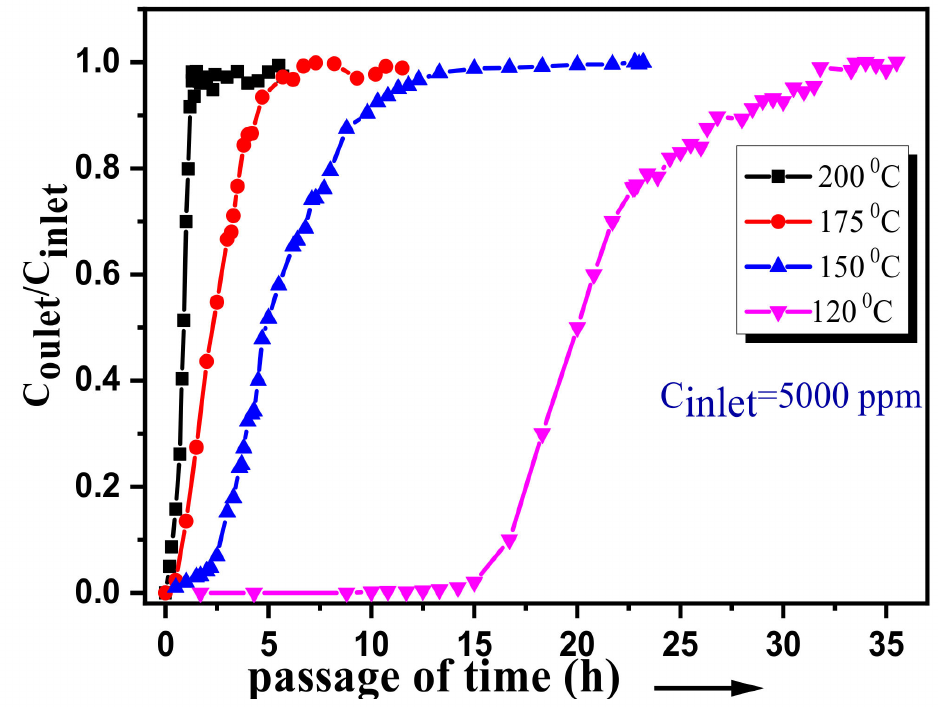
Figure 6. The experimental breakthrough curves of CB adsorption over the pristine ACF at various temperatures from 120 to 200 ◦ C. Tests carried out with 0.10 g ACF, 5000 ppm of initial CB/N 2 concentration, gas flow rate of 100 SCCM, and GHSV = 20,000 h − 1